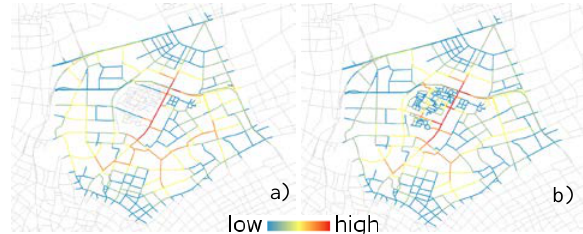
Figure 8. Betweenness centrality values calculated by original definition, a) when interior roads of Danwei and Xiaoqu are not integrated into the road network, b) when interior roads of Danwei and Xiaoqu are integrated into the road network